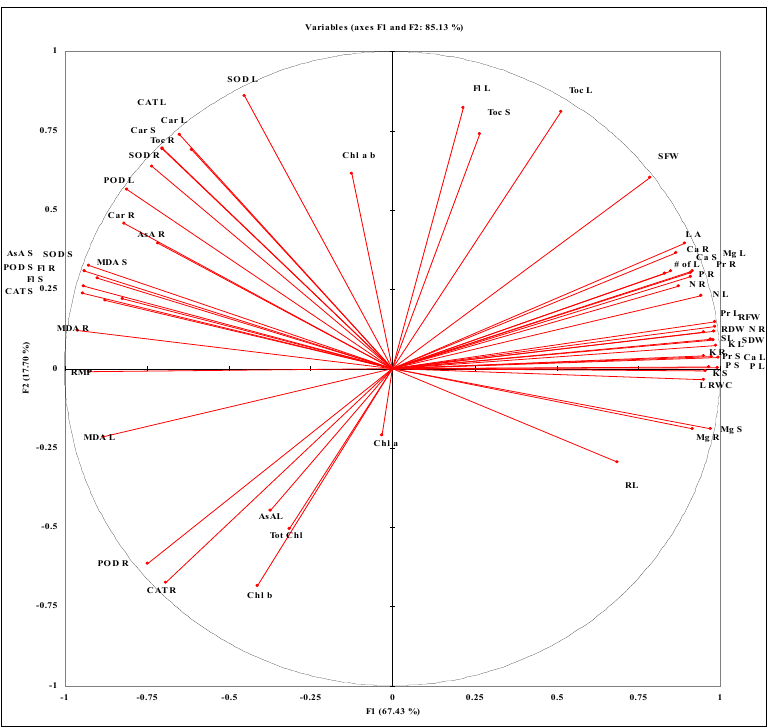
Figure 3. Principle component analysis of tocopherol levels in different plant tissues of maize with studied growth and physio ‐ biochemical attributes, and nutrient accumulation.